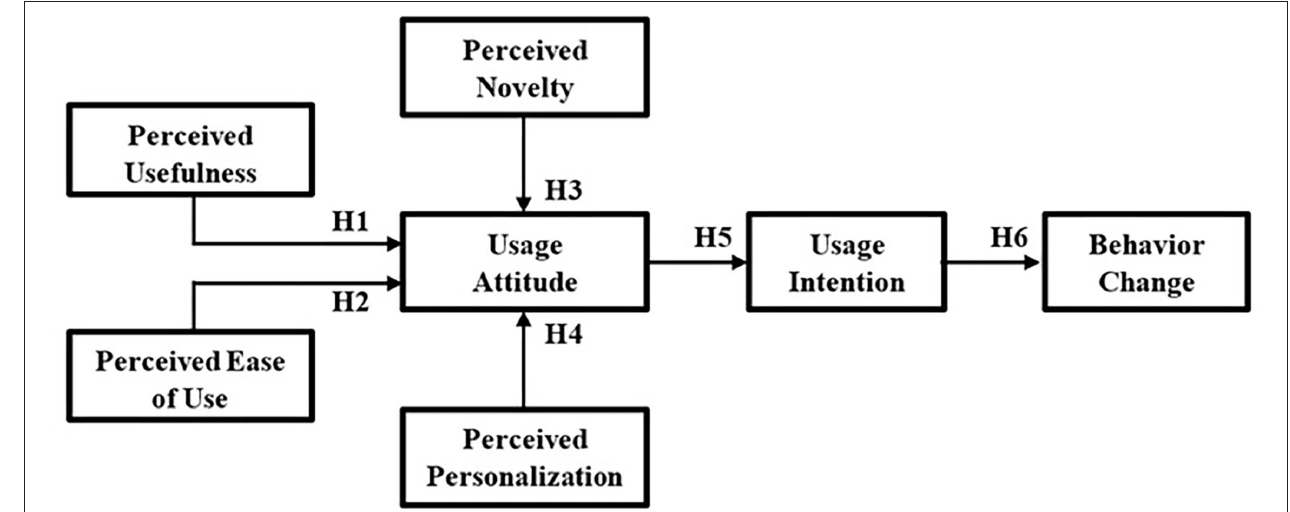
FIGURE 2 | The proposed mTAM framework and the corresponding hypothesis